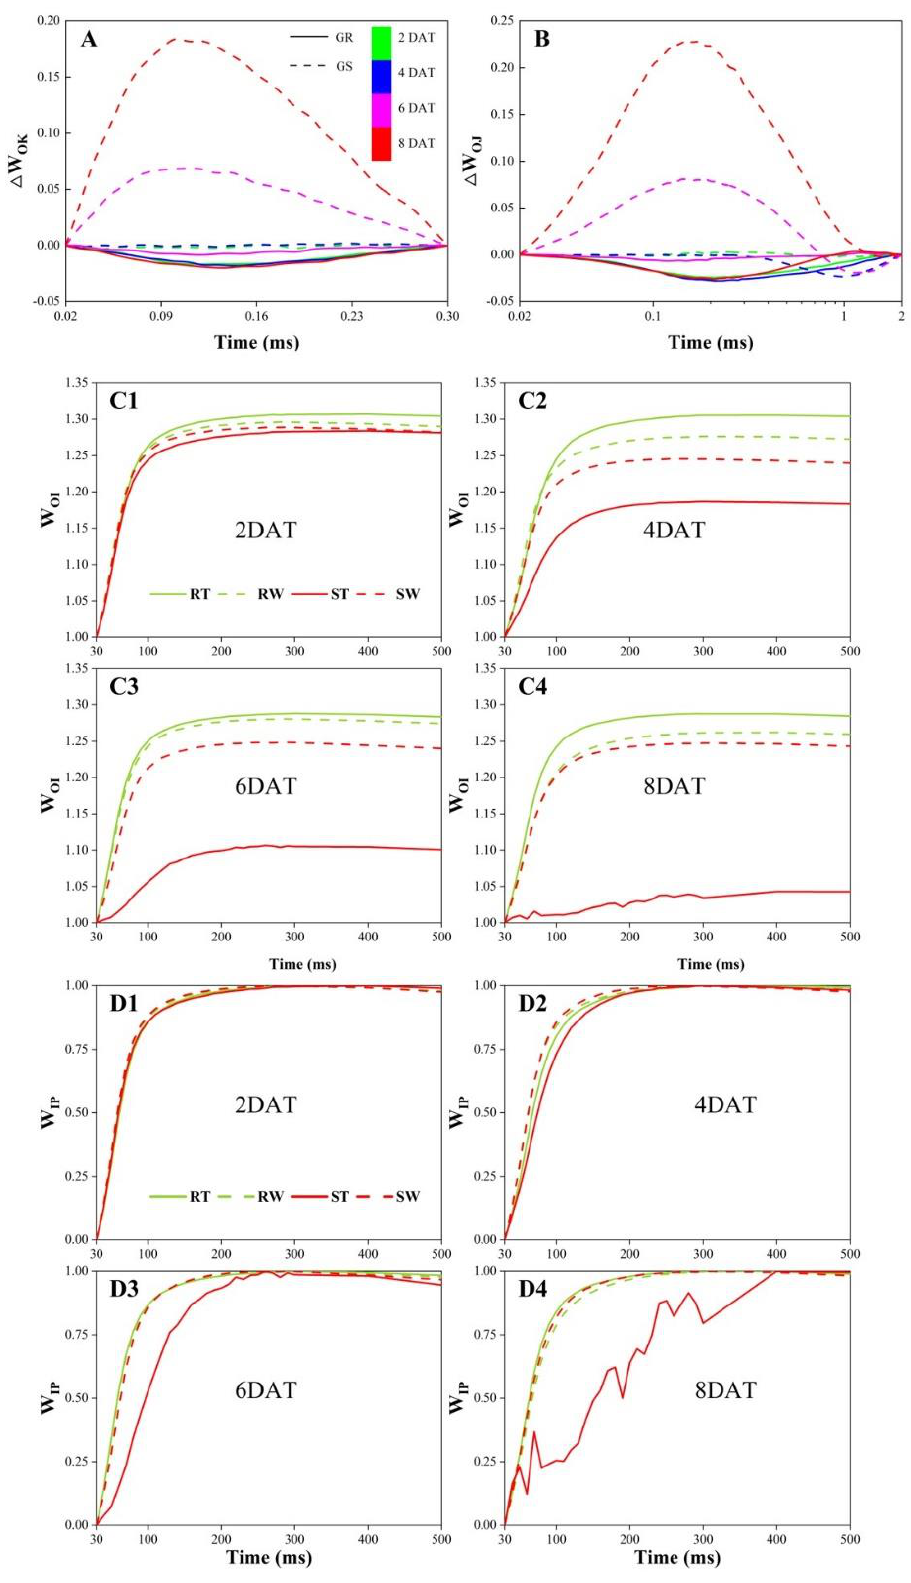
Figure 5. Changes in the ( A ) OK, ( B ) OI, ( C ) OP, and ( D ) IP-phase of fluorescence rise kinetics of different glyphosate-tolerance cultivars. W XY = ( F t − F 0 )/( F Y − F X ), Δ W XY = W XY (treatment) − W XY (control) ).